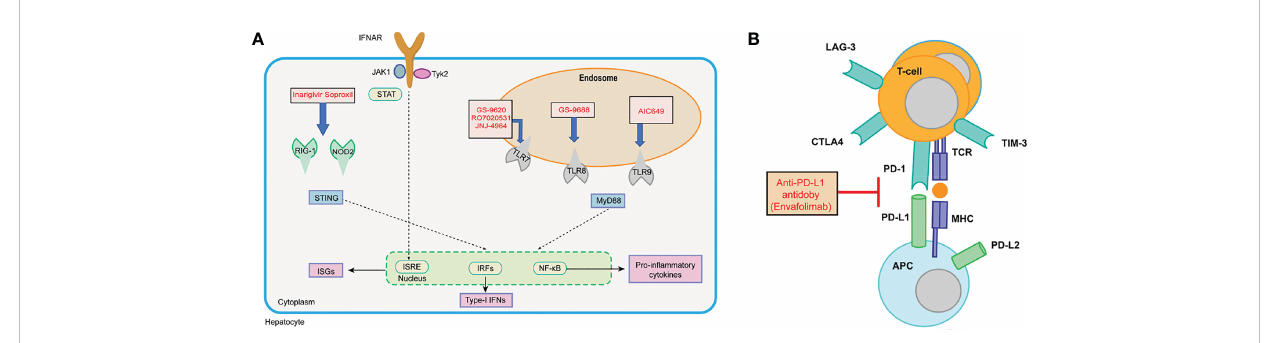
FIGURE 6 (A) Interferon and PRR agonism with IFN- a , RIG-I/NOD-2 agonists, TLR7 agonists, TLR8 agonist, and TLR9 agonists; (B) checkpoint inhibition with anti-PD-L1